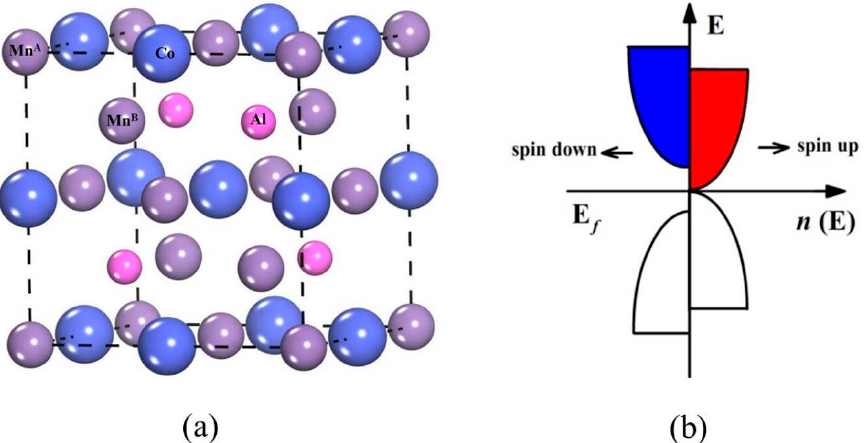
Figure 1. ( a ) Schematic representation of Mn 2 CoAl bulk structure. The schematic density of states of n (E) as a function of energy E is shown for ( b ) a spin gapless semiconductor. The occupied states are indicated by filled areas. Arrows indicate the majority and minority states.